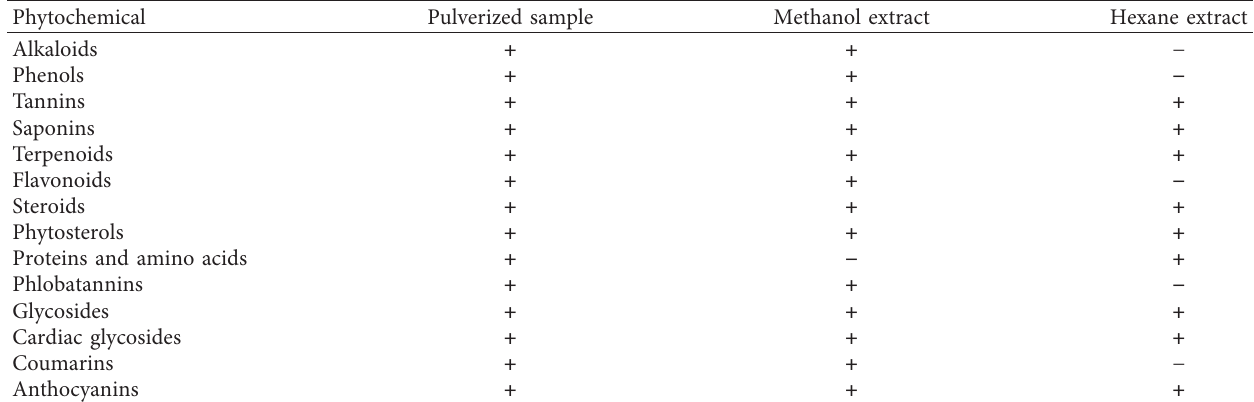
Table 1: Phytochemical constituents of the pulverized sample and extracts of V. camporum . Phytochemical